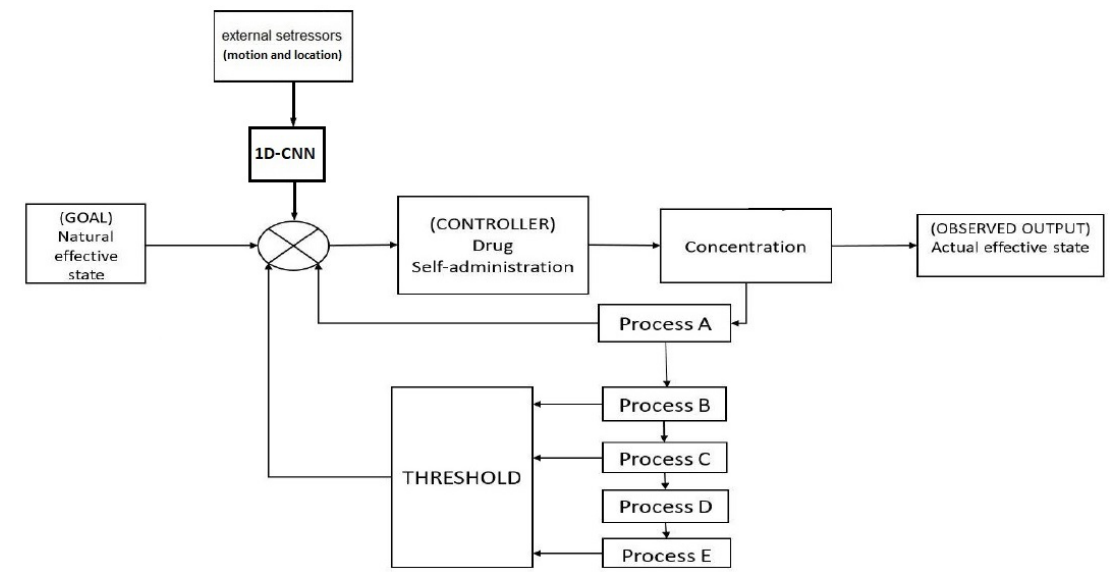
Figure 11. Smoking behaviour model utilizing machine learning. Data are collected and processed using the steps described in Figure 4. The 2 predictors are used as input to the 1D-CNN model.